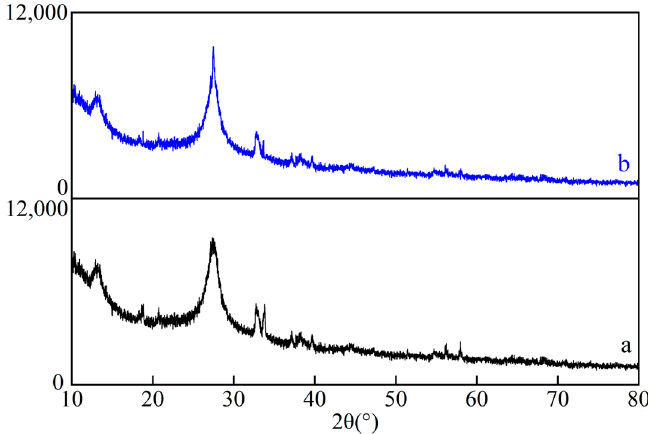
Figure 13. XRD patterns of Ag 2 O/g ‐ C 3 N 4 before ( a ) and after ( b ) the reaction.